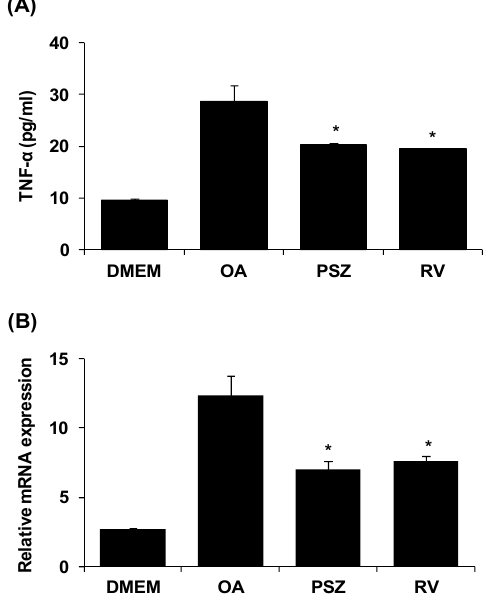
Figure 6 . Effects of Pinus densiflora Sieb. et Zucc. (PSZ) on TNF α production ( A ) and mRNA expression ( B ) in oleic acid (OA)-induced HepG2 cells. (A) HepG2 cells were treated with 100 μ g/mL PSZ. After treatment for 24 h, the supernatant was collected. TNF α production was quantified by ELISA. (B) HepG2 cells were treated with 100 μ g/mL PSZ. After treatment for 24 h, RNA was isolated and reverse-transcribed for RT-PCR analyses using the primers described in Table 1. Results are the mean ± SEM from three independent experiments. * p < 0.05 compared with the OA group. DMEM, control group; OA, oleic acid-treated group; PSZ, OA + Pinus densiflora Sieb. et Zucc. - treated group; RV, OA + resveratrol treated